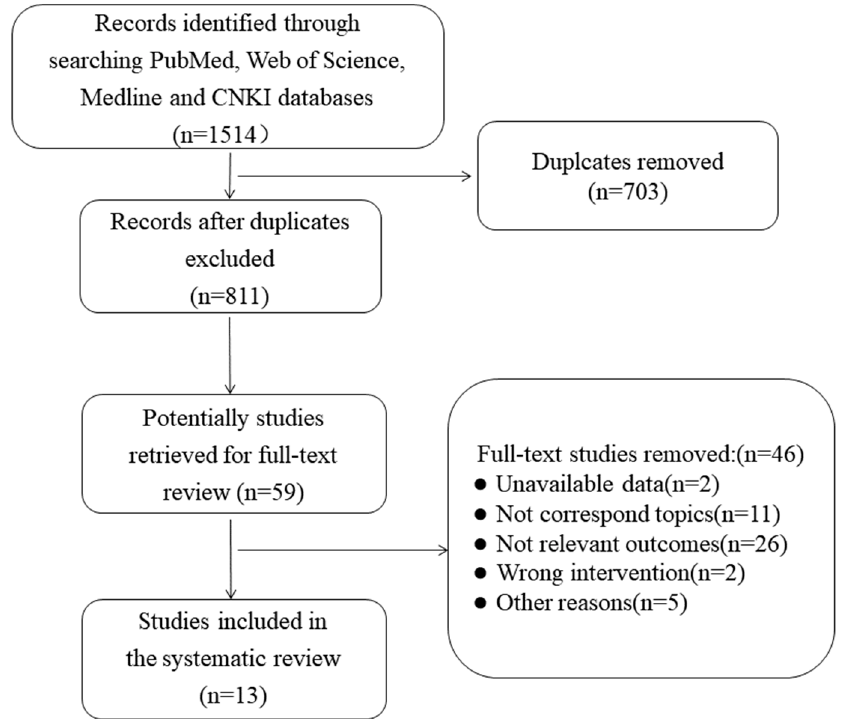
Figure 1. Flow chart of literature retrieval.